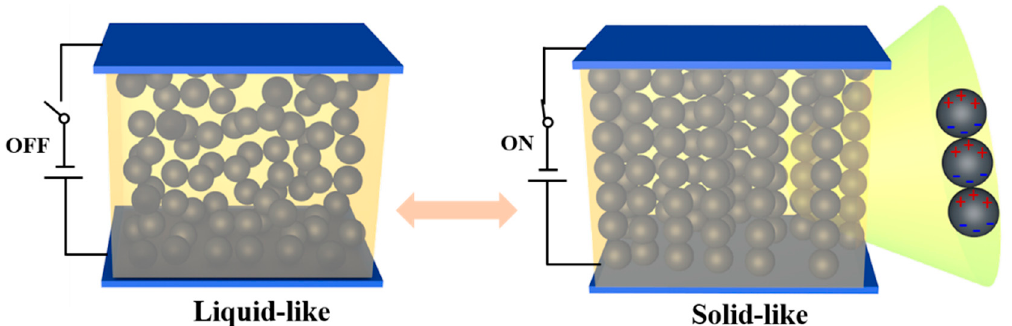
Scheme 1. Schematic diagram of transition between liquid-like and solid-like state for electrorheological (ER)